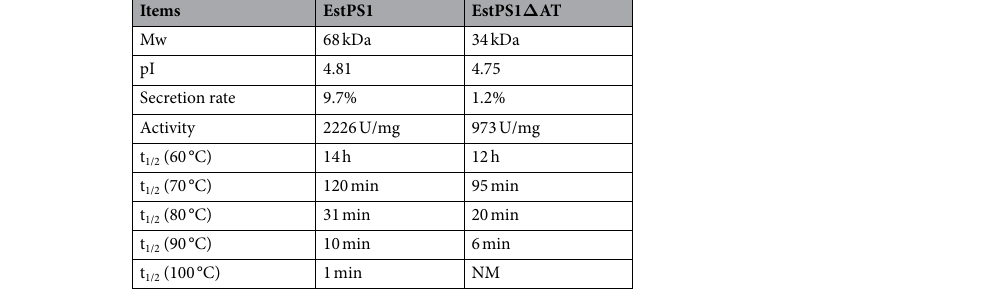
Table 1. Comparison between EstPS1 and EstPS1 Δ